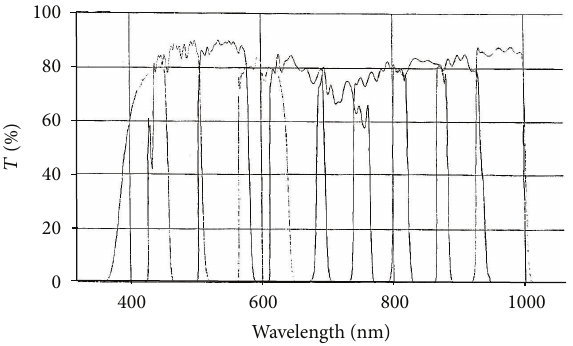
Figure 3: Spectral responses of the set of ten CVI Melles Griot interference filters used in the